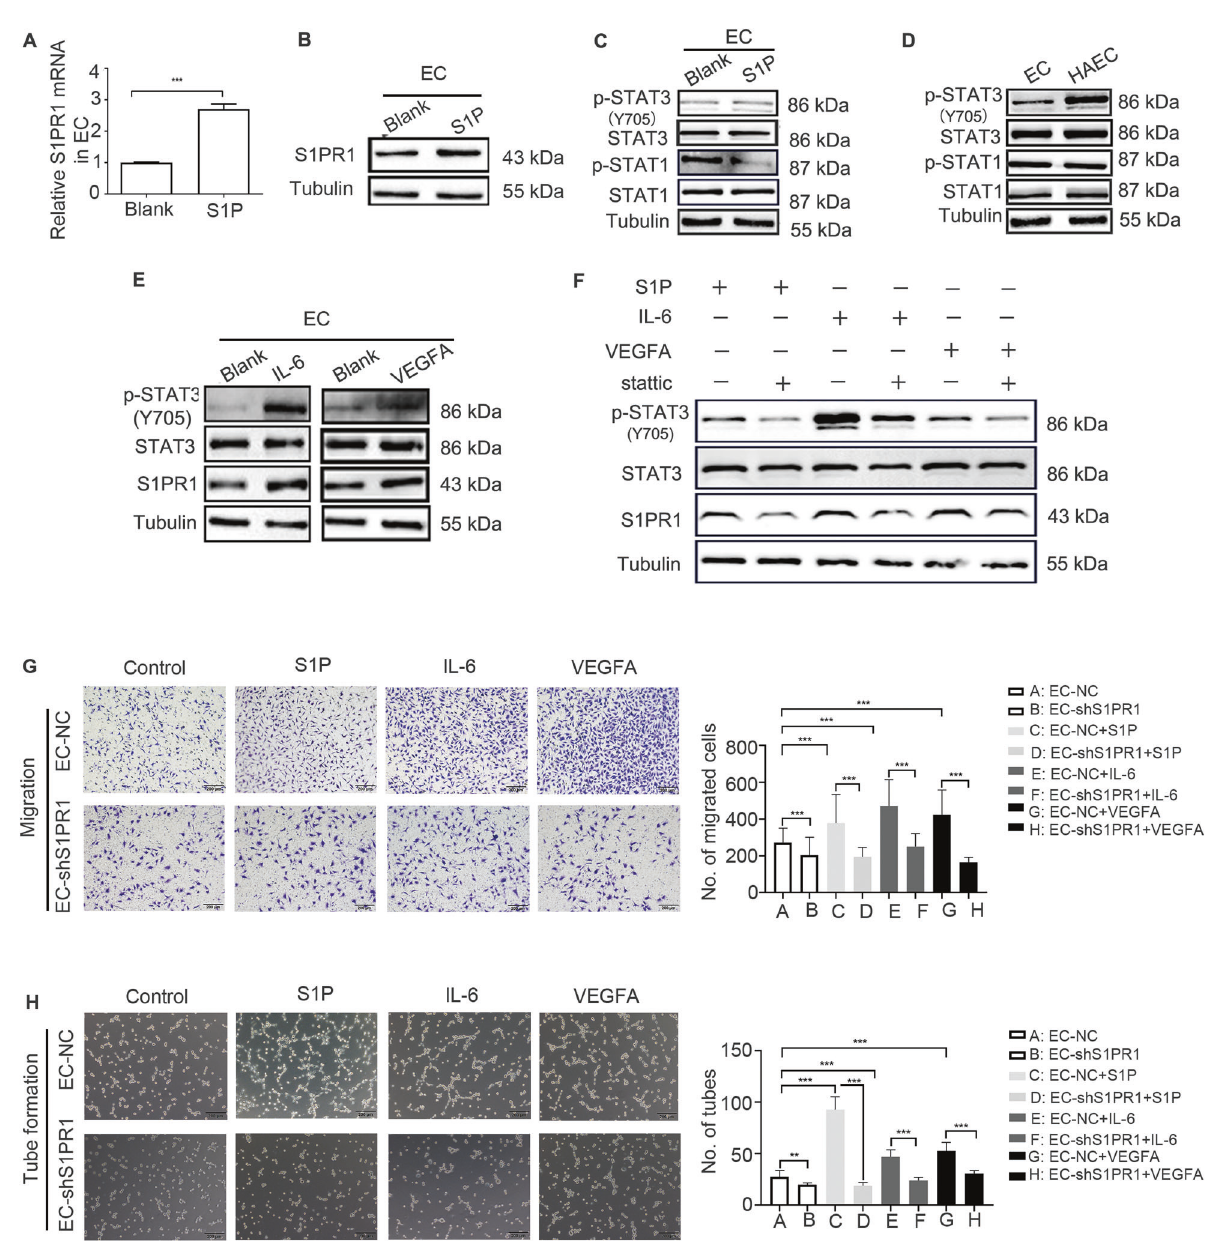
Fig. 4 S1PR1 was upregulated in HAECs via the phosphorylation of STAT3, which was stimulated by conditioned medium from HCC cells. A , B The mRNA ( A ) and protein ( B ) expression of S1PR1 in ECs treated with S1P (40 μ M) for 48 h was tested by real-time PCR and WB. C STAT1 and STAT3 phosphorylation (Y705) in ECs treated with S1P (40 μ M) for 48 h was assessed by WB. D STAT1 and STAT3 phosphorylation (Y705) in ECs and HAECs was detected by WB. E STAT3 phosphorylation (Y705) in ECs treated with IL-6 (25 ng/ml) or VEGFA (80 ng/ml) for 48 h was assessed by WB. F The expression of S1PR1 in HAECs treated with stattic (2 μ M) and proangiogenic factors, including IL-6 (25 ng/ml), VEGFA (80 ng/ml) and S1P (40 μ M) for 48 h was detected by WB. G , H The migration ( G ) and tube-formation ( H ) of ECs and ECs with S1PR1 downregulation treated with S1P (40 μ M), IL-6 (25 ng/ml) or VEGFA (80 ng/ml) were tested. Scale bar: 200 μ m. Data are presented as the means ± SDs, and an independent t test was used to analyse the signi fi cant difference. *** P < 0.05, ** P < 0.01. Cell Death and Disease (2022)